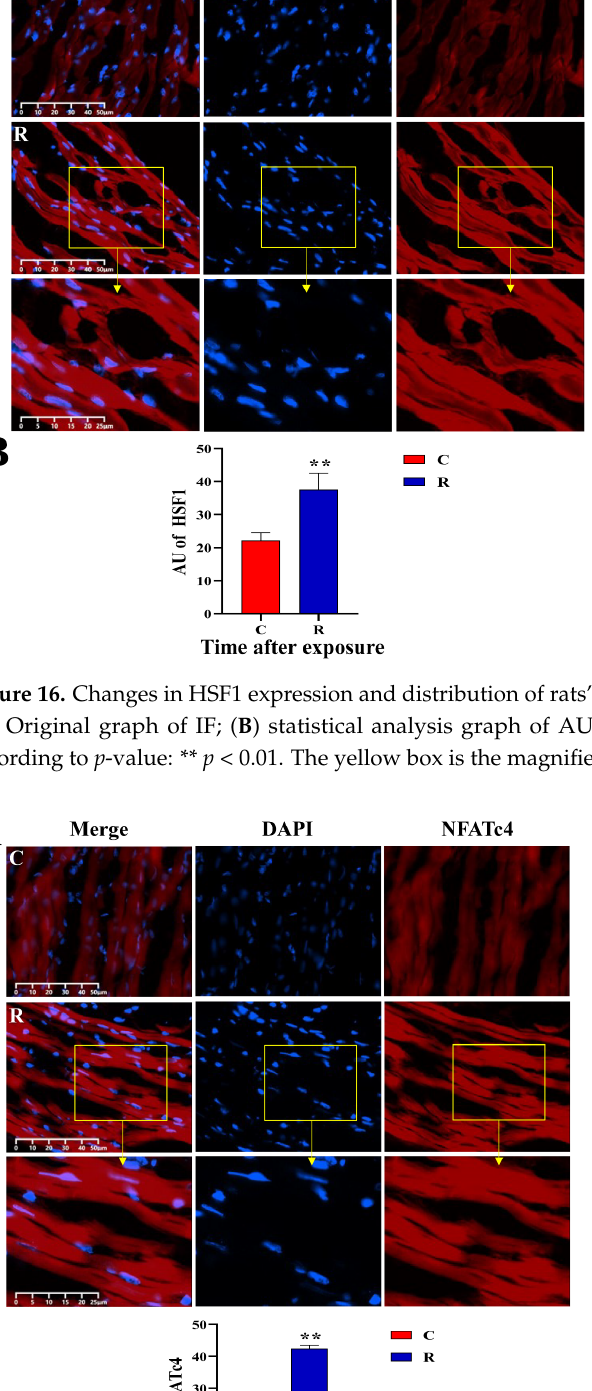
Figure 15. Changes in p-JNK expression and distribution of rats’ myocardium after S-band radia- tion. ( A ) Original graph of IF; ( B ) statistical analysis graph of AU. Signi fi cance signs were classi fi ed according to p -value: * p < 0.05. The yellow box is the magni fi ed area.